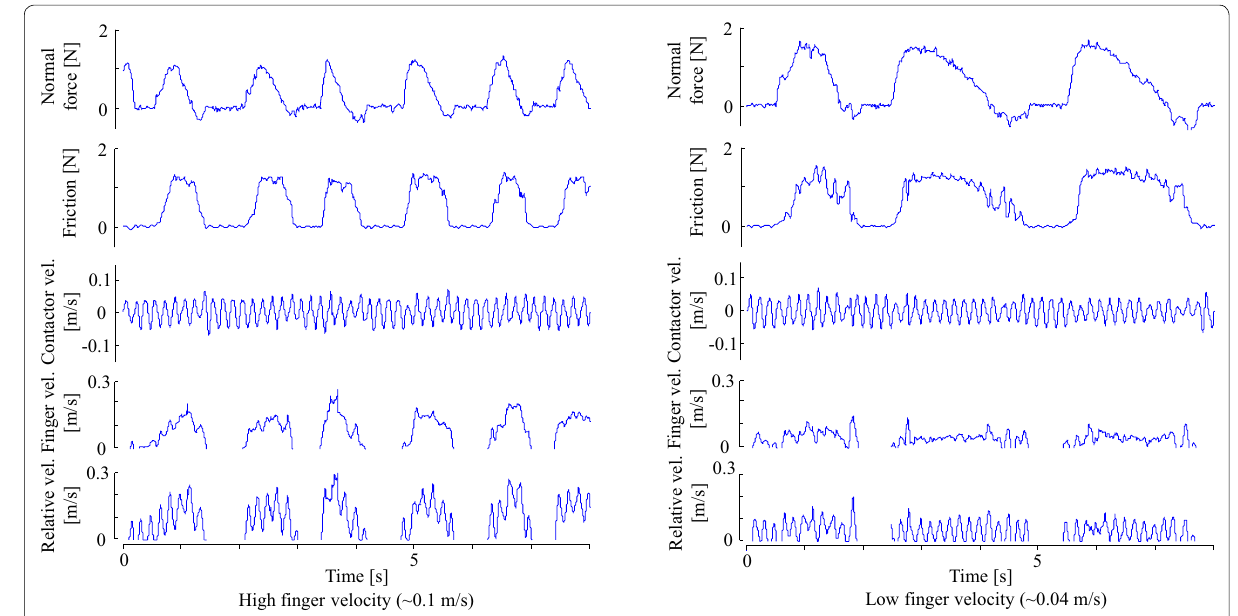
Fig. 11 Temporal course of physical quantities observed during experiments. Left Those when the intended finger velocity was 0.1 m/s and the relative velocity was constantly positive while touching the contactor. Right Those when the intended finger velocity was 0.04 m/s. Stimulus condi- tion was #2 for which the frequency and amplitude were 6 Hz and 0.625 mm, respectively. While the normal force was nearly zero, the finger was not touching the contactor and the finger velocity is not shown. Because the finger movement was reciprocating, its velocity was alternately posi- tive and negative. The contactor was being touched only when the finger velocity was positive. The sinusoidal vibration of the contactor was largely maintained while it was being touched. The relative velocity is the difference between the finger velocity and that of the